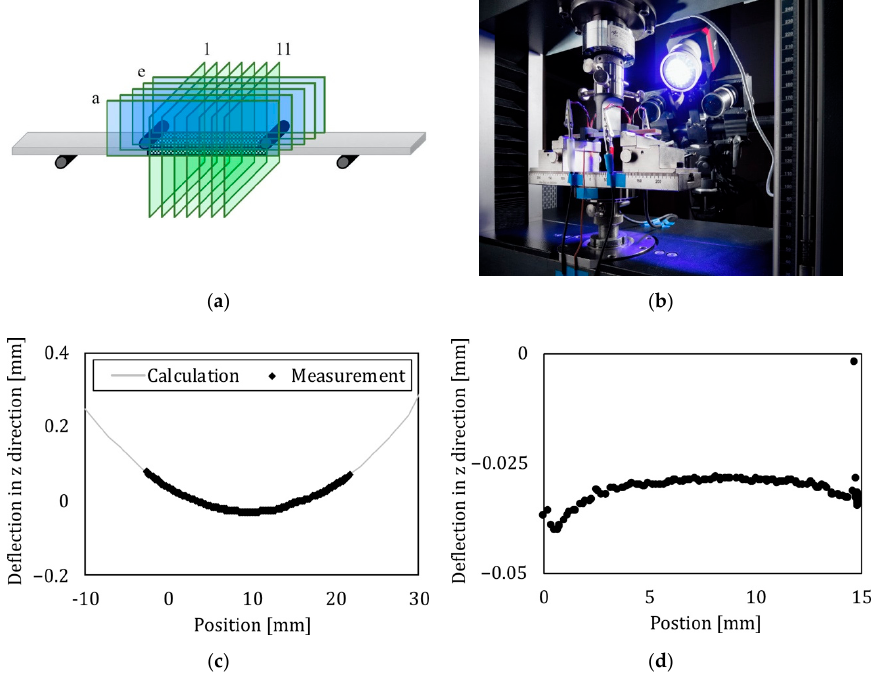
Figure 4. Optical analysis of a bending beam to investigate the geometric deformation. ( a ) Position of the sections where the deflection is extracted. Blue shows the sections in beam direction, green the sections between the inner load entry points. ( b ) Optical system to measure the displacement of the samples during mechanical tests. The system uses two cameras to get the displacement information. For better contrast, the sample has a random pattern on the surface and the surface is illuminated with blue light. ( c,d ) Deflection of the beam in the inner section between the force entry points. The curve is one of six similar deflection lines. C shows the bending of the beam, while D is the buckling of the surface.